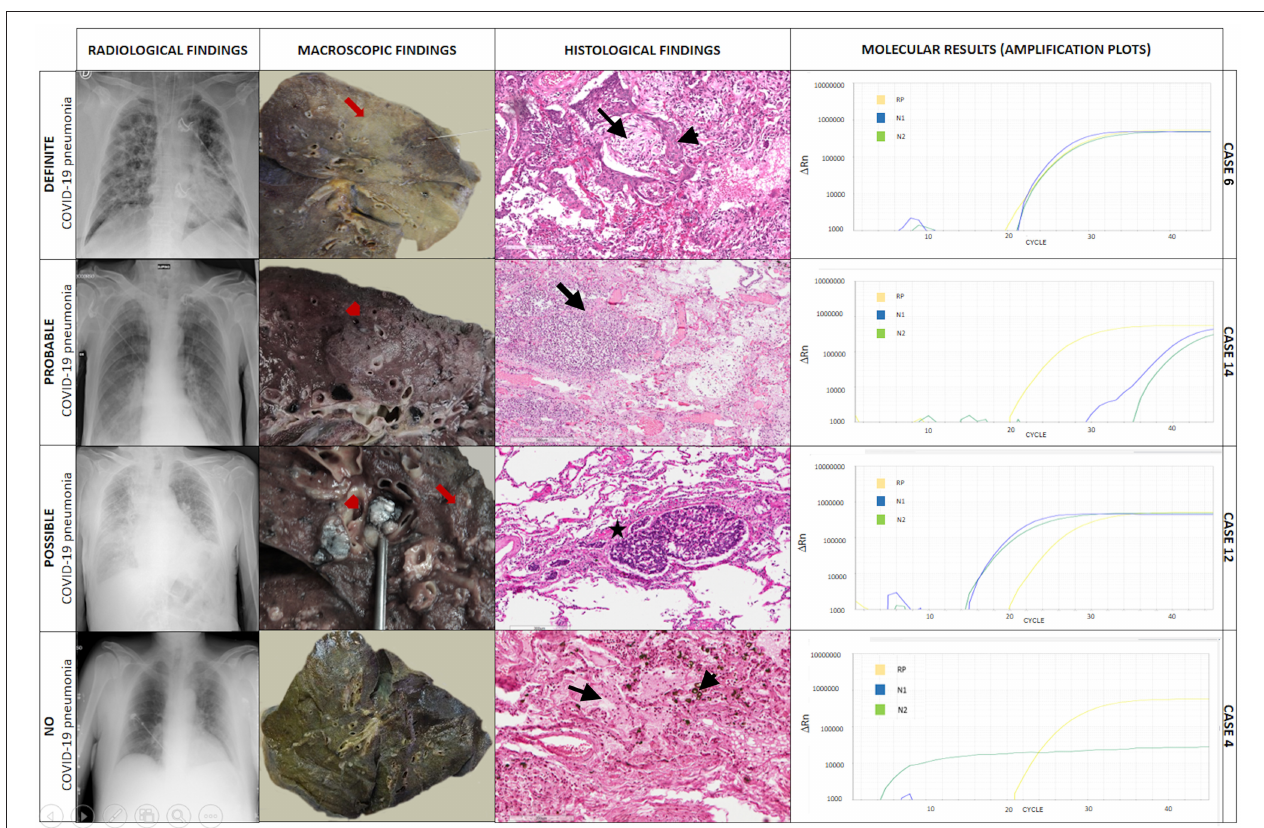
FIGURE 2 | Explicative cases of definite, probable, possible, and non-COVID-19 pneumonia. In case 6, chest X-ray showed diffuse, bilateral ground-glass and interstitial opacities, and pulmonary consolidations. The gross examination showed diffuse lung parenchyma consolidation (formalin-fixed lung, red arrow). At histology, multiple foci of diffuse alveolar damage and organizing pneumonia were seen (black arrow) with squamous metaplasia (black arrowhead). Hematoxylin-eosin, scale bar: 200 µ m. Tissue molecular analysis for SARS-CoV-2 was positive. In case 14, chest X-ray demonstrated ground-glass opacities and pleural effusion. The gross examination showed a grayish granular and friable area in the lung (red arrowhead). At histology areas of granulocyte, infiltration with abscess-like features was seen (bacterial pneumonia, black arrow). Hematoxylin-eosin, scale bar: 300 µ m. Tissue molecular analysis for SARS-CoV-2 was positive. In case 12, chest X-ray showed signs of pulmonary vascular congestion, interstitial thickening, ground-glass opacities, bilateral pulmonary consolidations, and pleural effusion. The gross examination showed nodular lymphangitis and lymph node metastasis (red arrow). At histology multiple foci of neoplastic thrombi of squamous cell carcinoma were seen (black star). Hematoxylin-eosin, scale bar: 300 µ m. Tissue molecular analysis for SARS-CoV-2 was positive. In case 4, chest X-ray demonstrated bilateral signs of pulmonary vascular congestion and ground-glass opacities in the left lung. The gross examination showed the lung with a greenish/brown appearance (formalin-fixed lung). At histology, edema (black arrow) and diffuse infiltration of macrophages with intracytoplasmic bile pigment granules (black arrowhead) were detected. Hematoxylin eosin, scale bar: 200 µ m. Tissue molecular analysis for SARS-CoV-2 was negative. 1 Rn, the normalized reporter value (Rn) of the experimental reaction minus the Rn value of the baseline signal generated by the instrument; RP, human RNase P gene; N1, region of virus nucleocapsid; N2, region of virus